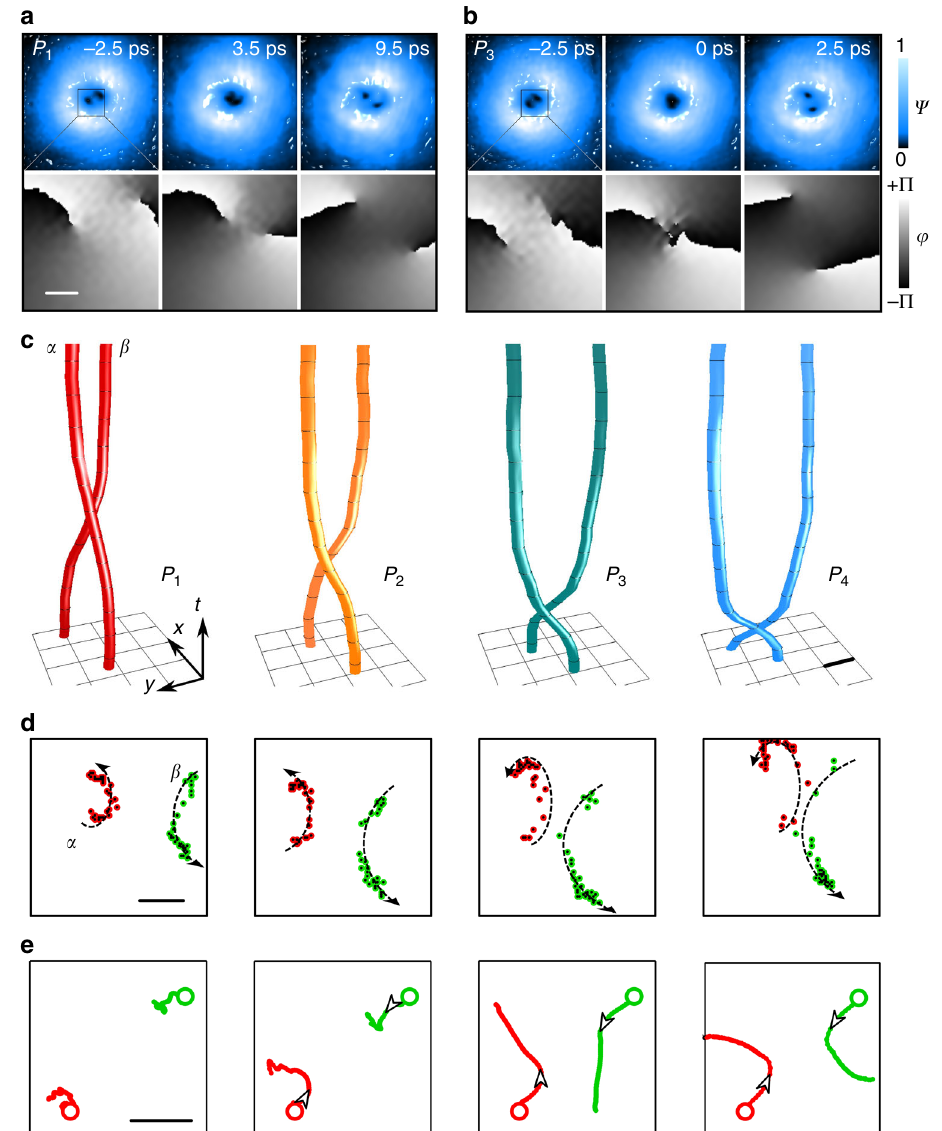
Fig. 2 Vortex scattering. a , b Amplitude and phase maps of the polariton fl uid at three time frames for a low ( P 1 , a ) and a larger ( P 3 , b ) initial density. The phase maps correspond to the small square area of the density maps. c The ( x , y , t ) vortex trajectories (time range Δ t = − 2.5 – 9.5 ps, step δ t = 0.5 ps) for four increasing initial populations P 1 – 4 (the number of polaritons are reported in the caption to Fig. 3). d Vortex-scattering maps for the same four powers, in the Δ t = − 2.5 – 13.5 ps timespan. The two arc arrows are guides for the eye to help understand their movement over time. The average and top speeds of the phase singularities are on the order of ≤ 1 μ m ps − 1 and ~10 μ m ps − 1 , respectively. e (arranged in increasing pump power) Shows the numerical vortex orbits leading to scattering for large powers. Initial positions are depicted with circles. All the scale bars are 5 μ m while the small square box in the top rows of a , b is 20 × 20 μ m